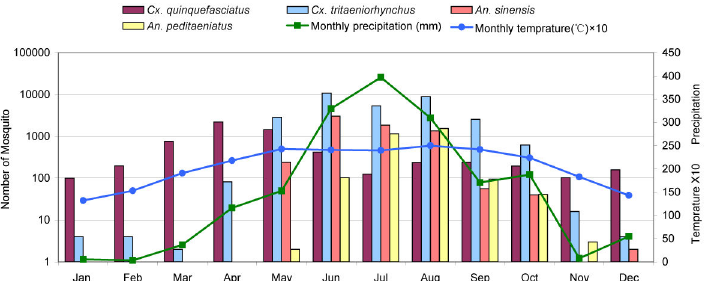
Figure 3. Monthly average temperature, total precipitation and abundance of the four predominant mosquito species collected in Mangshi, 2010.